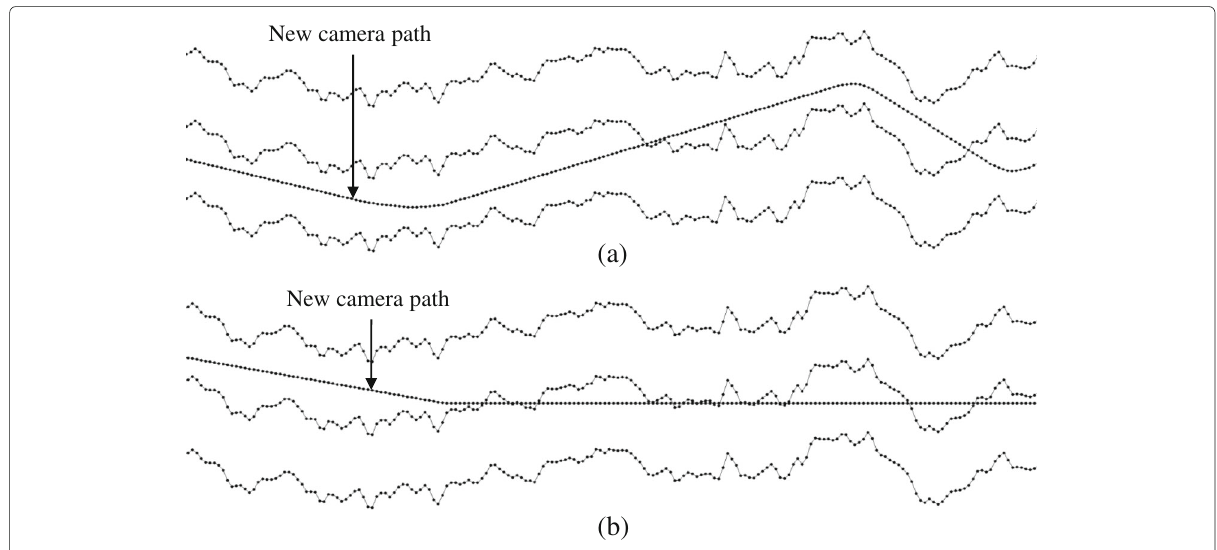
Fig. 9 a Without C S ( n , i ) and b with C S ( n , i ) in Eq. (4). K is set at 10